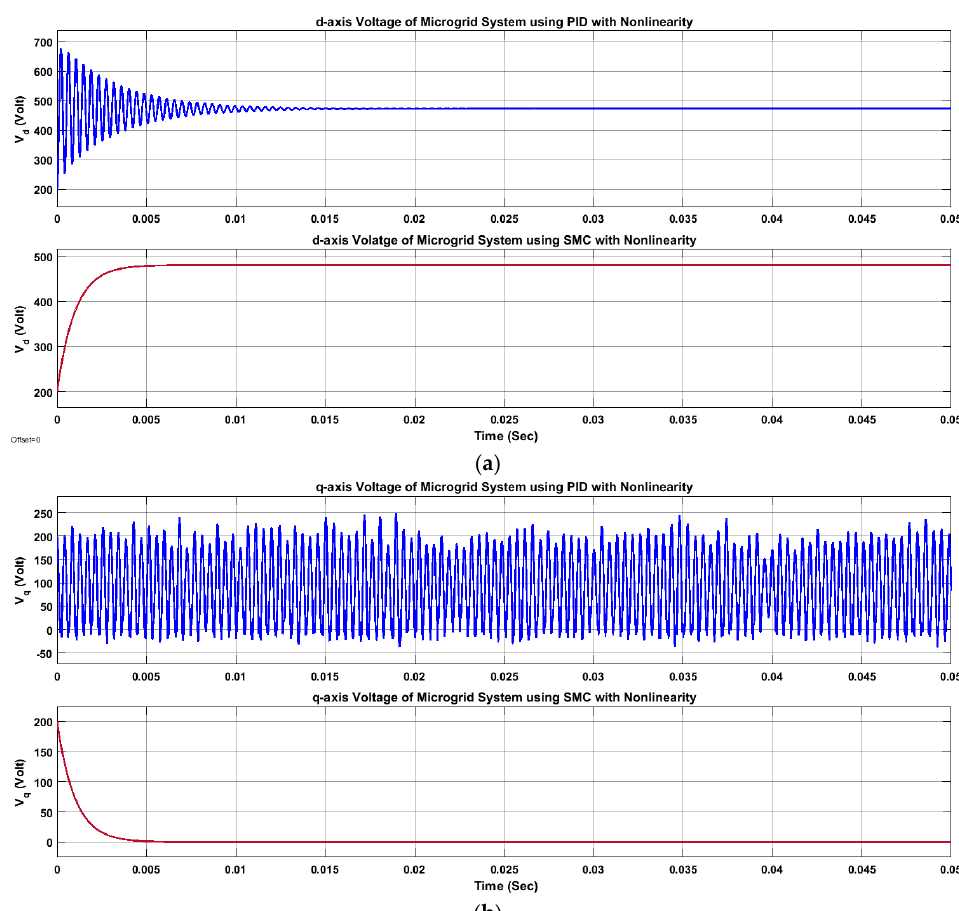
Figure 11. Performance comparison between PID (blue colored) and SMC (red colored) in the case of ( a ) real axis output voltage ( V d ) and ( b ) reactive axis output voltage ( V q ) for nonlinear system application.